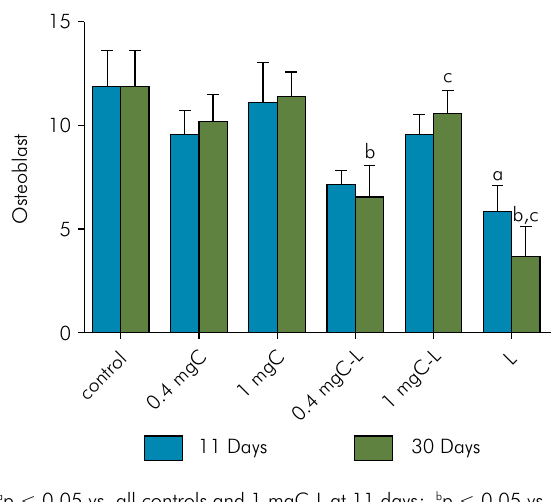
Figure 5. Mean osteoblast numbers in the study